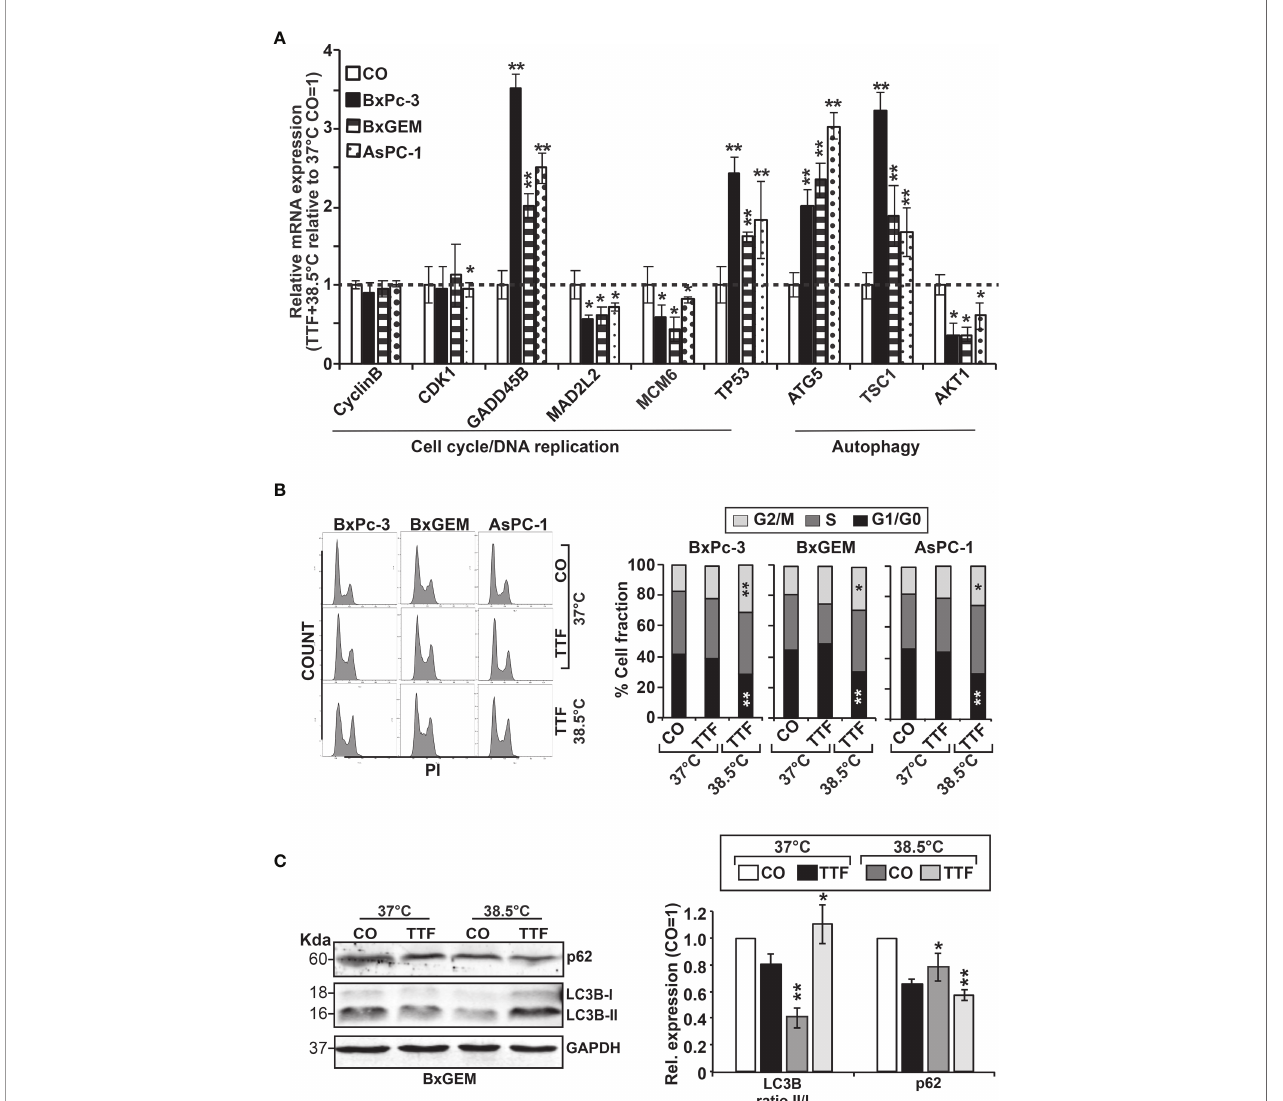
FIGURE 6 | Functional studies con fi rm TTField plus hyperthermia-mediated autophagy, the cell cycle and DNA signaling. (A) BxPc-3, BxGEM and AsPC-1 cells were cultivated at 38.5°C plus TTFields or at 37°C in the controls, followed by isolation of mRNA three days later and RT-qPCR analysis. The gene expression level of each gene was normalized to that of GAPDH , and the relative mRNA expression of hyperthermia/TTFields compared to control cells is shown. The primer sequences are given in Supplementary Table S1 , and a comparison of the expression levels is provided in Table 1 . The results are presented as relative gene expression. For calculation, the 2 − DD Ct method of relative quanti fi cation given in the equation was used. (B) PDAC cells were seeded in 96-well plates and cultivated at 37°C in the absence (CO) or presence of TTFields (TTF) or were cultivated at 38.5°C plus TTFields (TTF+38.5°C) for 72 h. Then, the progression of the cell cycle was analyzed by staining the cells with propidium iodide, followed by fl ow cytometry. The results are shown as fl ow cytometry pro fi les (left) and cell cycle quanti fi cation in bar graphs (right). (C) The cells were cultivated at 37°C in the absence (CO) or presence of TTFields (TTF) or at 38.5°C plus TTFields, as indicated, and 72 h later, the proteins were isolated, and the expression of p62 and LC3 was examined by the use of speci fi c antibodies and Western blot analysis. GAPDH served as the control for equal conditions. Three independent experiments were performed at least in triplicate, and the data are presented as the means ± SD; *P < 0.05, **P <